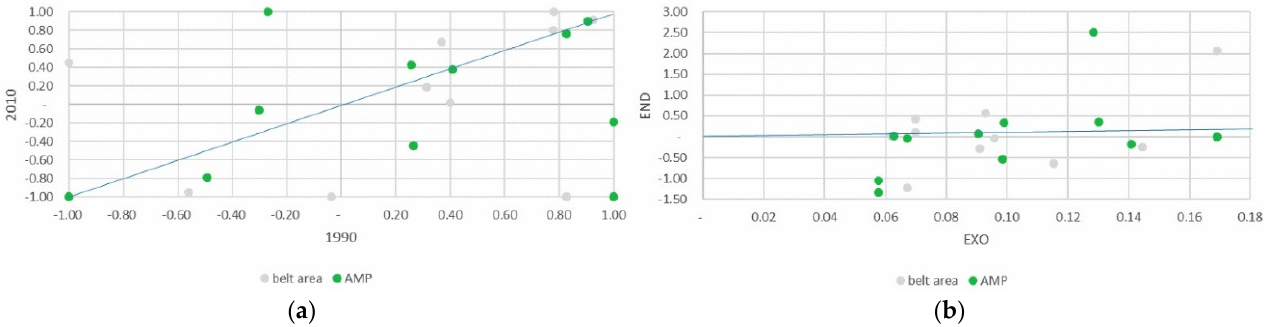
Figure 23. ( a , b ) AMP- PSI and DPSI for cattle. Source: Drawn up by the authors using data provided by the ISTAT.